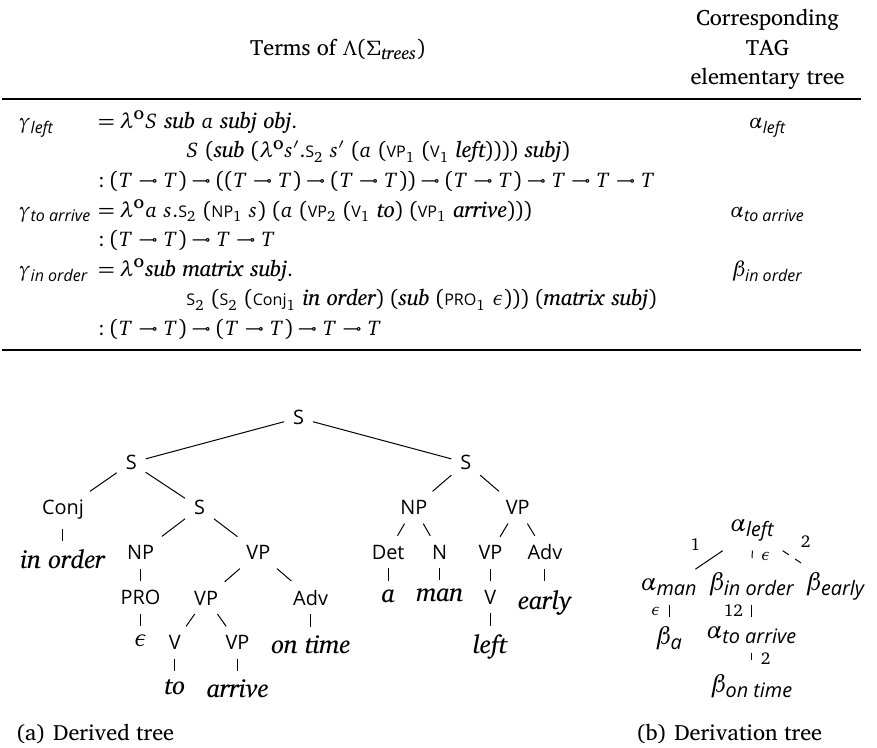
Figure 32: Derived tree and derivation tree for In order to arrive on time, a man left early (38) C (39) G TAG ( C (40) G derived trees ◦ G TAG ( C